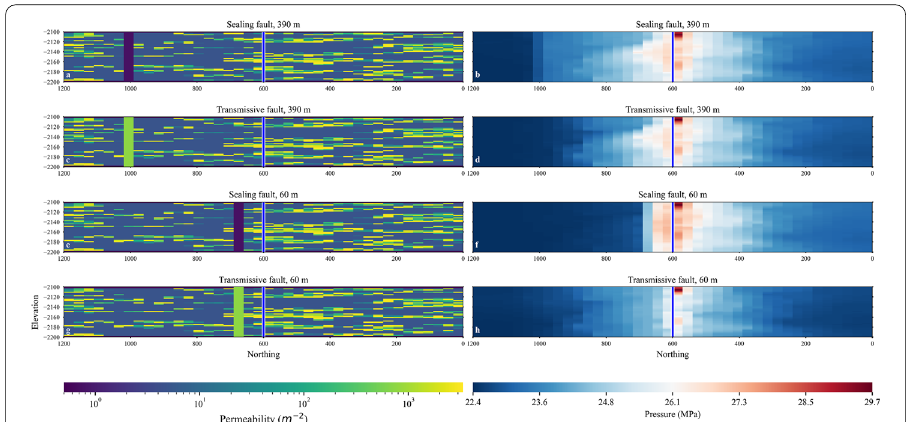
Fig. 9 Vertical cross-section of the reservoir at the injection well location showing the permeability (left column) and corresponding pressure distribution (right column) in the DSSM reservoir. A sealing fault at an FWD of 390 m ( a ) and 60 m ( c ) from the injector well and a transmissive fault at an FWD of 390 m ( b ) and 60 m ( d ) distance from the injector well are shown. The injector well is marked by a blue line. Data shown for an 303.15 K injection temperature and a flowrate of 9000 m 3 /